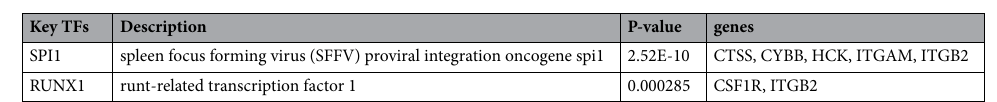
Table 2. Key transcriptional factors (TFs) of hub